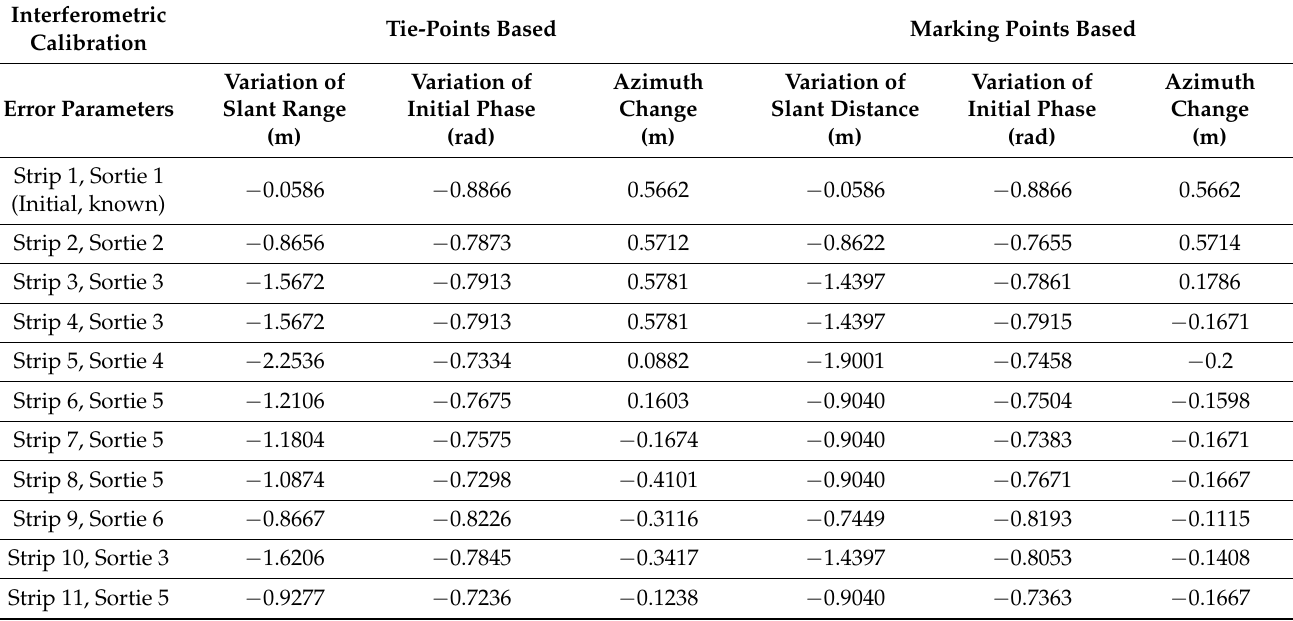
Table 2. Interferometric calibration results of 11 adjacent strips of 6 different